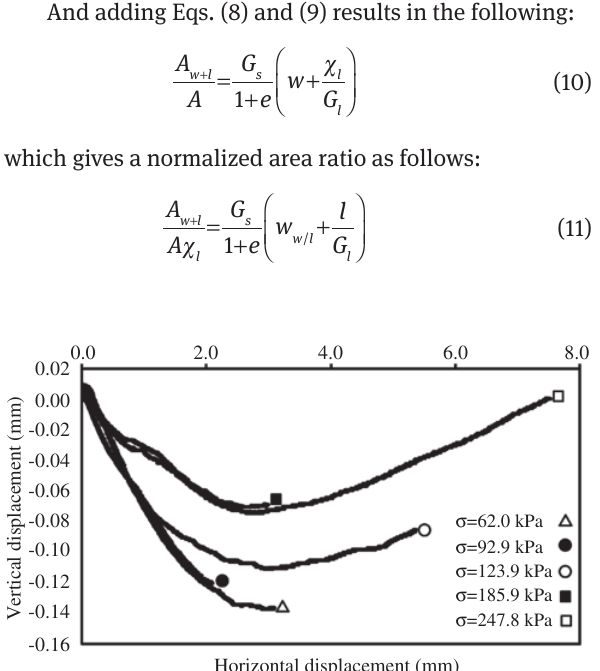
Figure 4 Peak shear stress versus normal stress for χ D, and